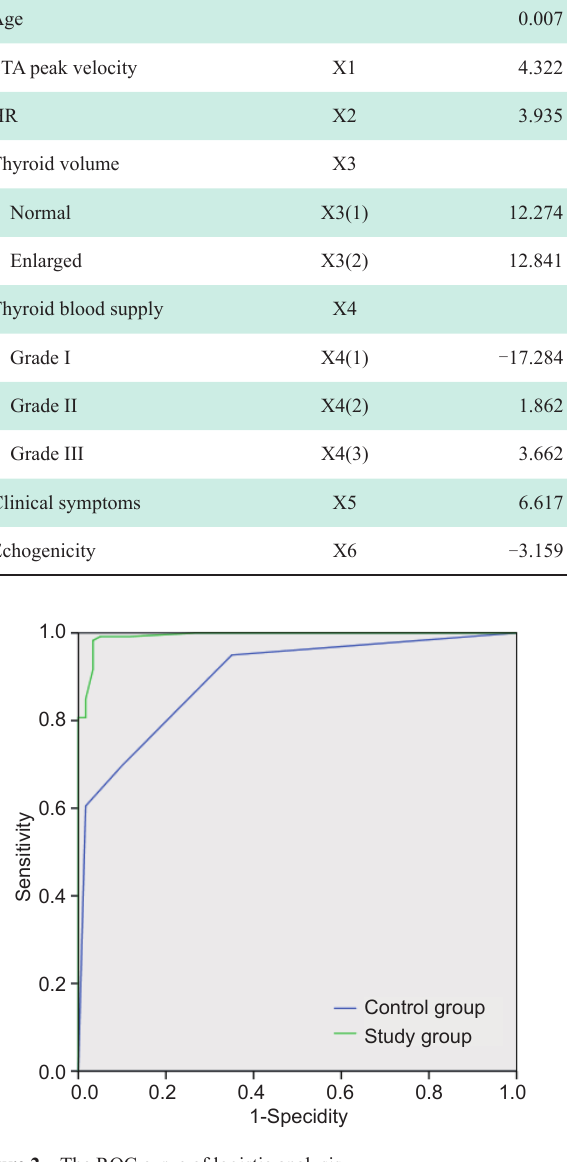
Figure 2 The ROC curve of logistic analysis.